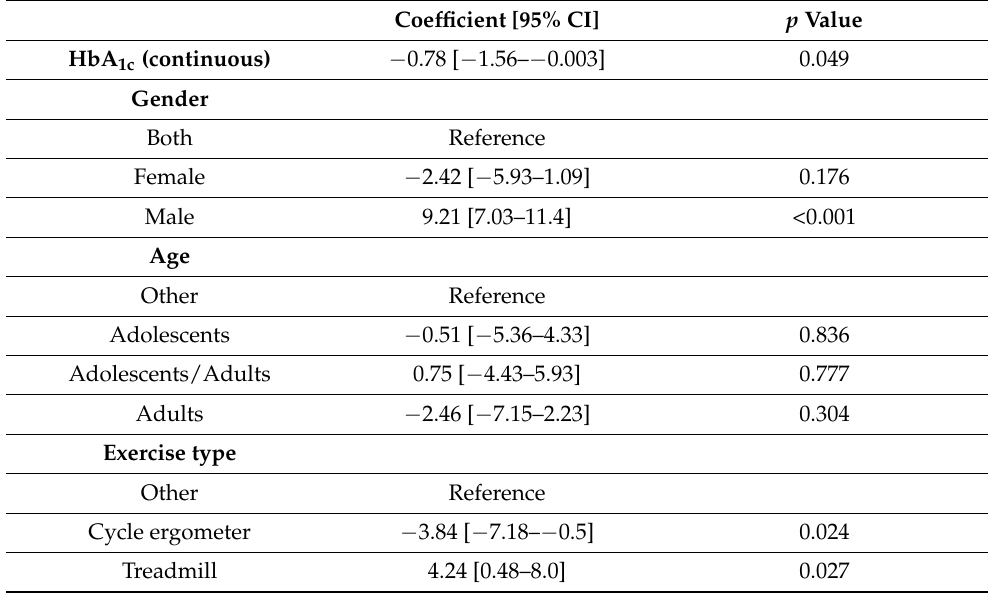
Table 2. Multivariate meta-regression of study